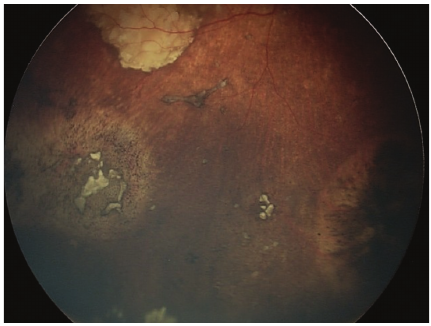
Figure 3: Fundoscopic exam revealing the same patient with intraocular retinoblastoma after treatment with intra-arterial